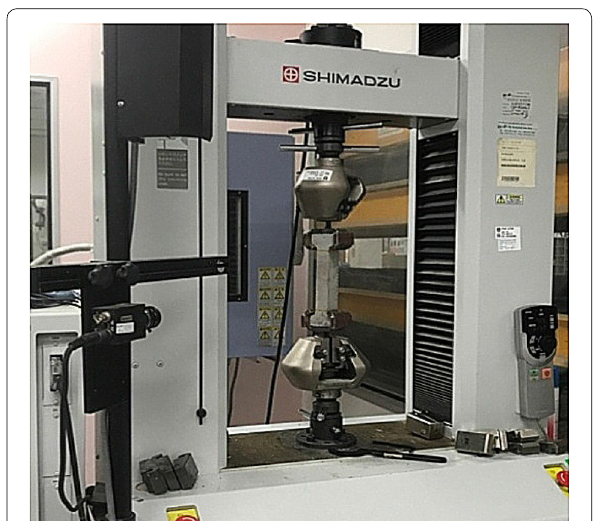
Fig. 4 Uniaxial tensile test